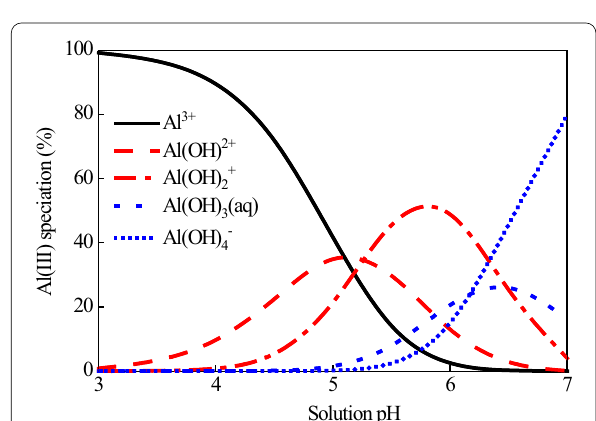
Fig. 4 Al(III) speciation determined by Visual MINTEQ software at pH 3–7 ([Al(III)] 50 μmol L − 1 =